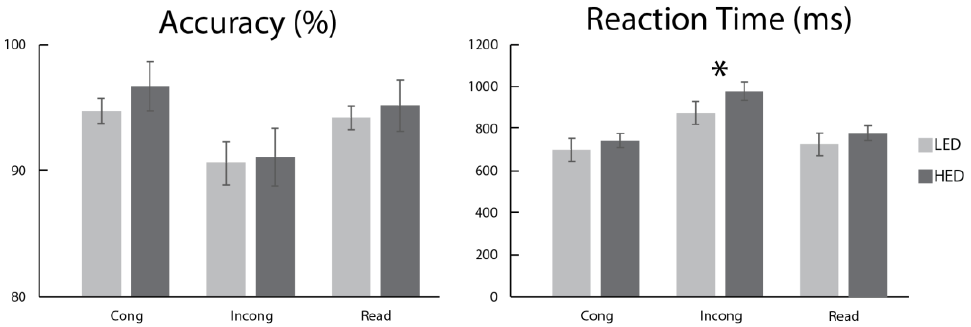
Figure 2. Lower accuracy and longer reaction times (RT) on INCONG trials confirm the Stroop interference effect. HED participants show longer RT time only on incongruent trials: * p < 0.05.